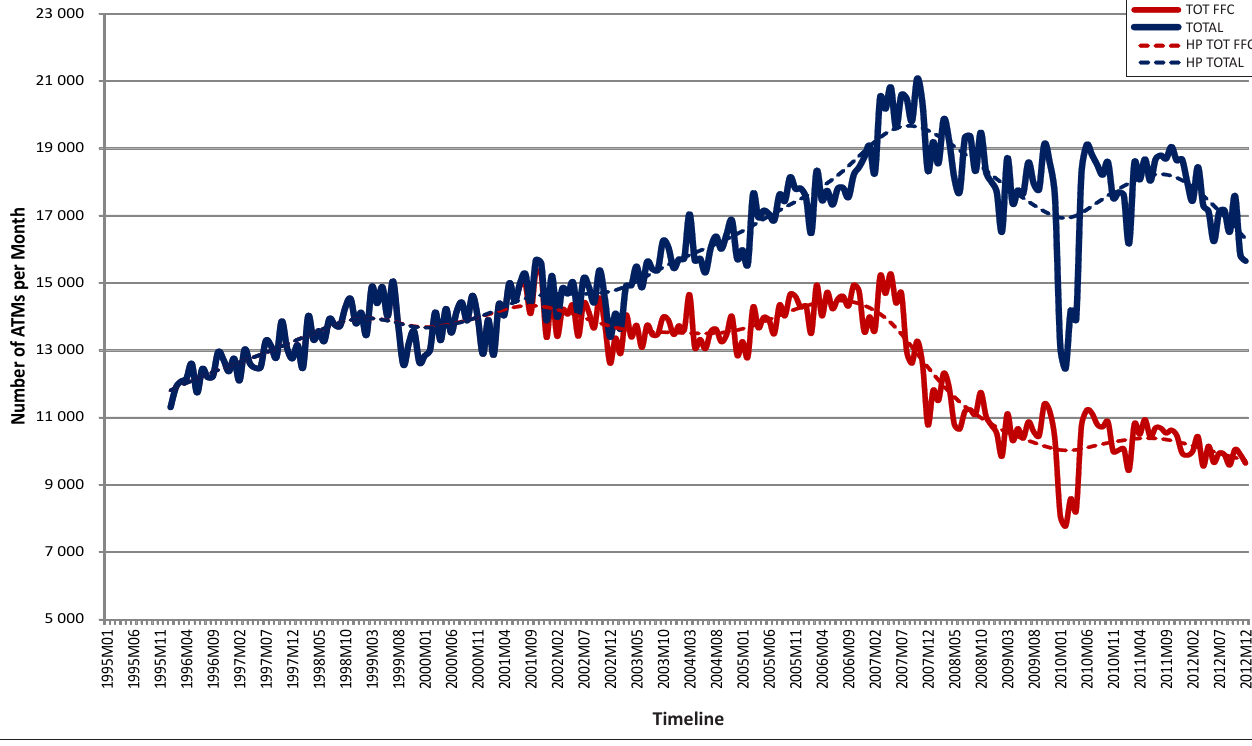
FIGURE 2: Air Traffic movements on the ‘Golden Triangle’ (total scheduled domestic arrivals and departures).